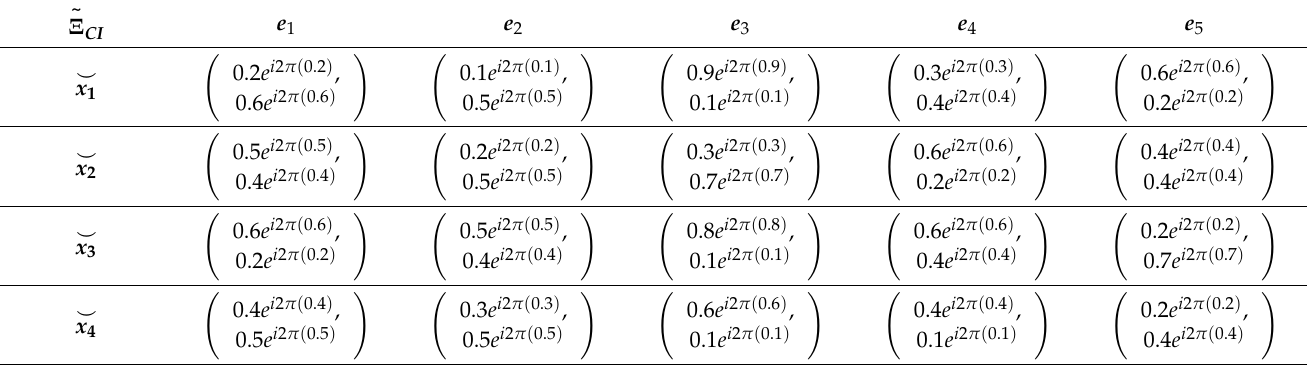
Table 1. Expressions of the complex intuitionistic fuzzy soft